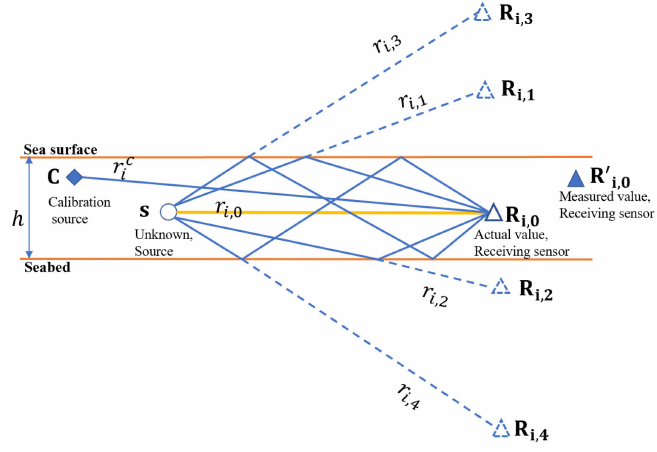
Figure 1. Underwater multipath signal location